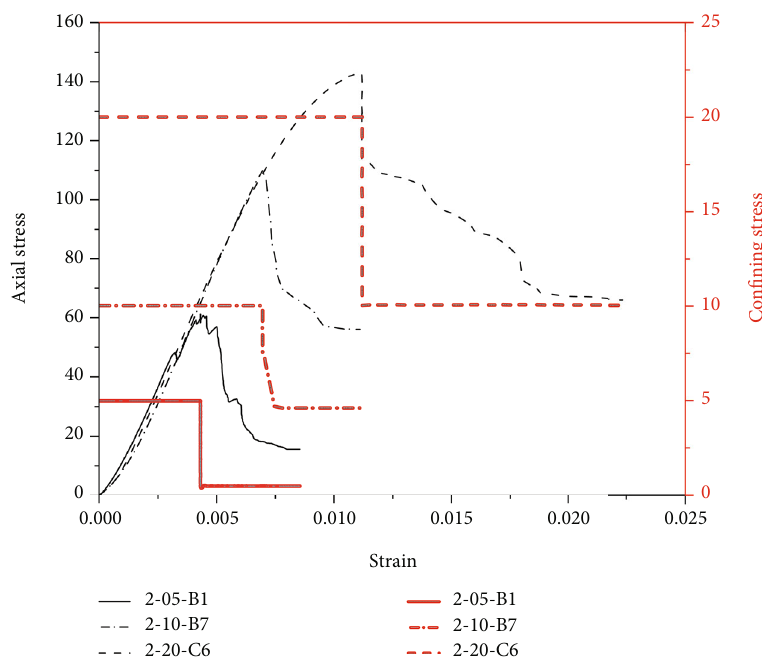
Figure 7: Axial stress/con fi ning pressure-strain relations of Scheme 2 under di ff erent con fi ning